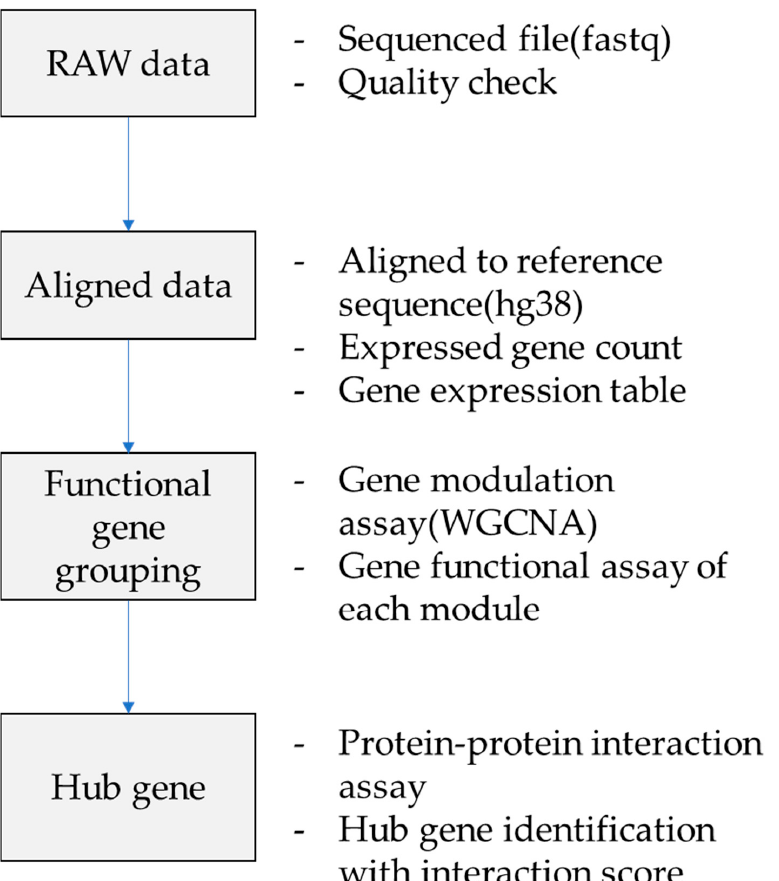
Figure 1. Diagram of hub gene identification process.